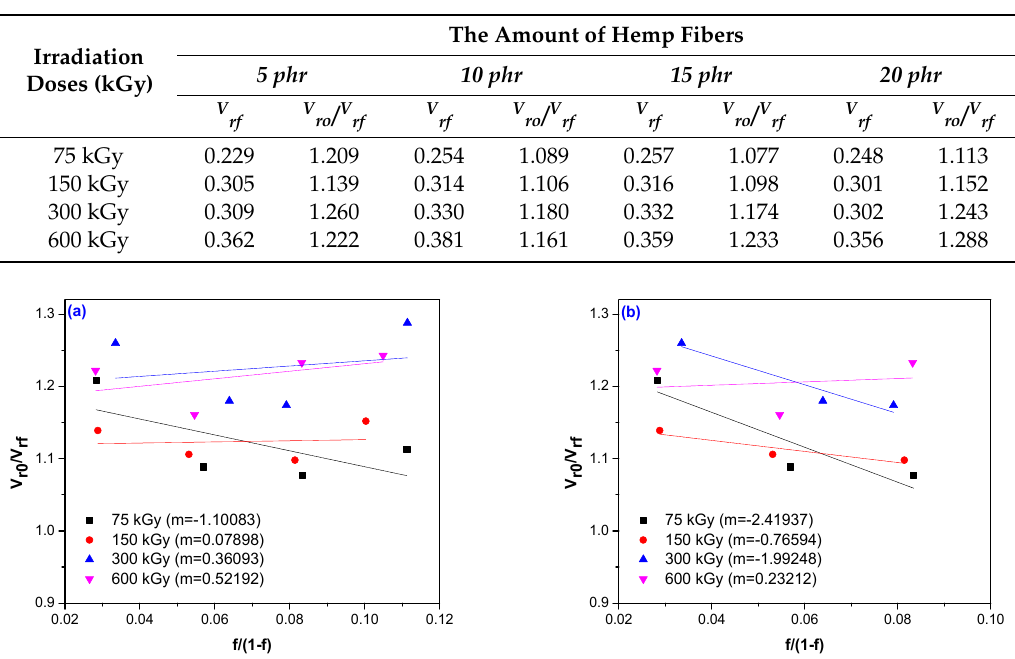
Table 4. Vrf and Vro / Vrf values of composites based on EPDM and flax fiber depending on the amount of hemp fibers and the irradiation dose.